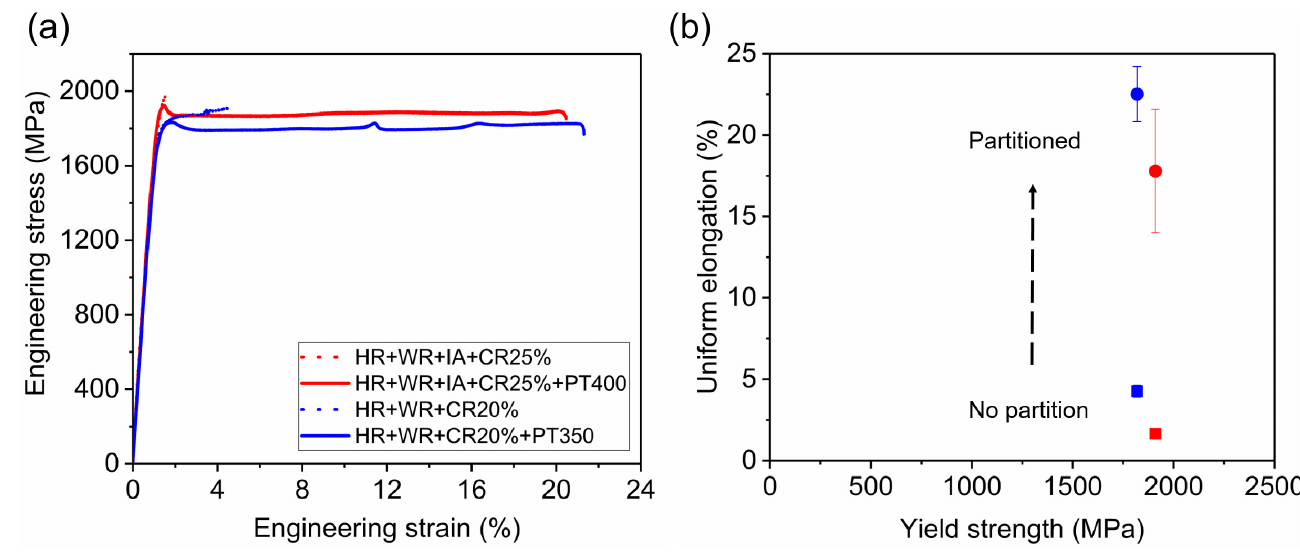
Figure 10. ( a ) Engineering stress–strain curves of HR + WR + IA + CR25% + PT400 sample, HR + WR + CR20% + PT350 sample, and corresponding samples without the partitioning process. ( b ) Uniform elongation versus yield strength for samples in ( a ), the yield strength is determined as the upper yield point for D&P samples, the square dots represent samples without partitioning process, the circular dots represent samples with partitioning process, the colors in ( b ) are in consistent with colors in ( a ).